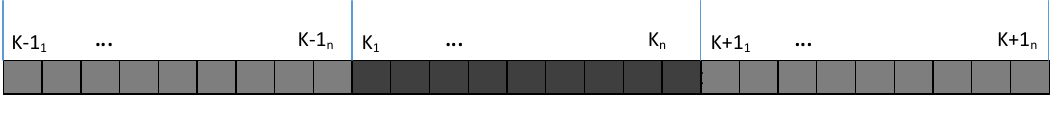
Figure 6. Cellular-neighborhood reading.